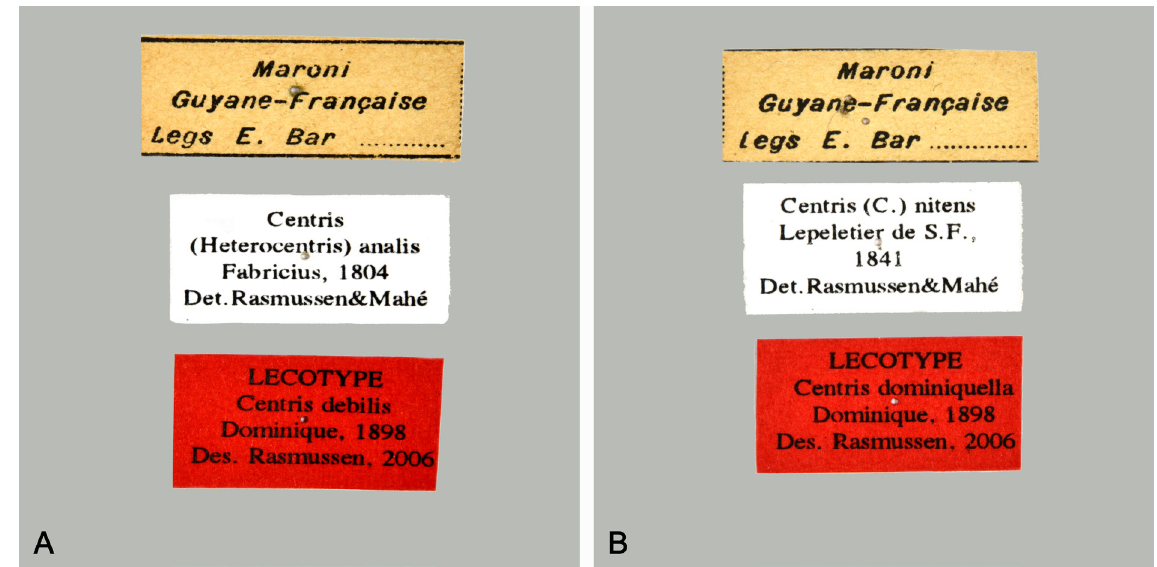
Fig. 1. Data labels. A . Centris debilis Dominique, 1898 (lectotype ♂). B . Centris dominiquella Dominique, 1898 (lectotype